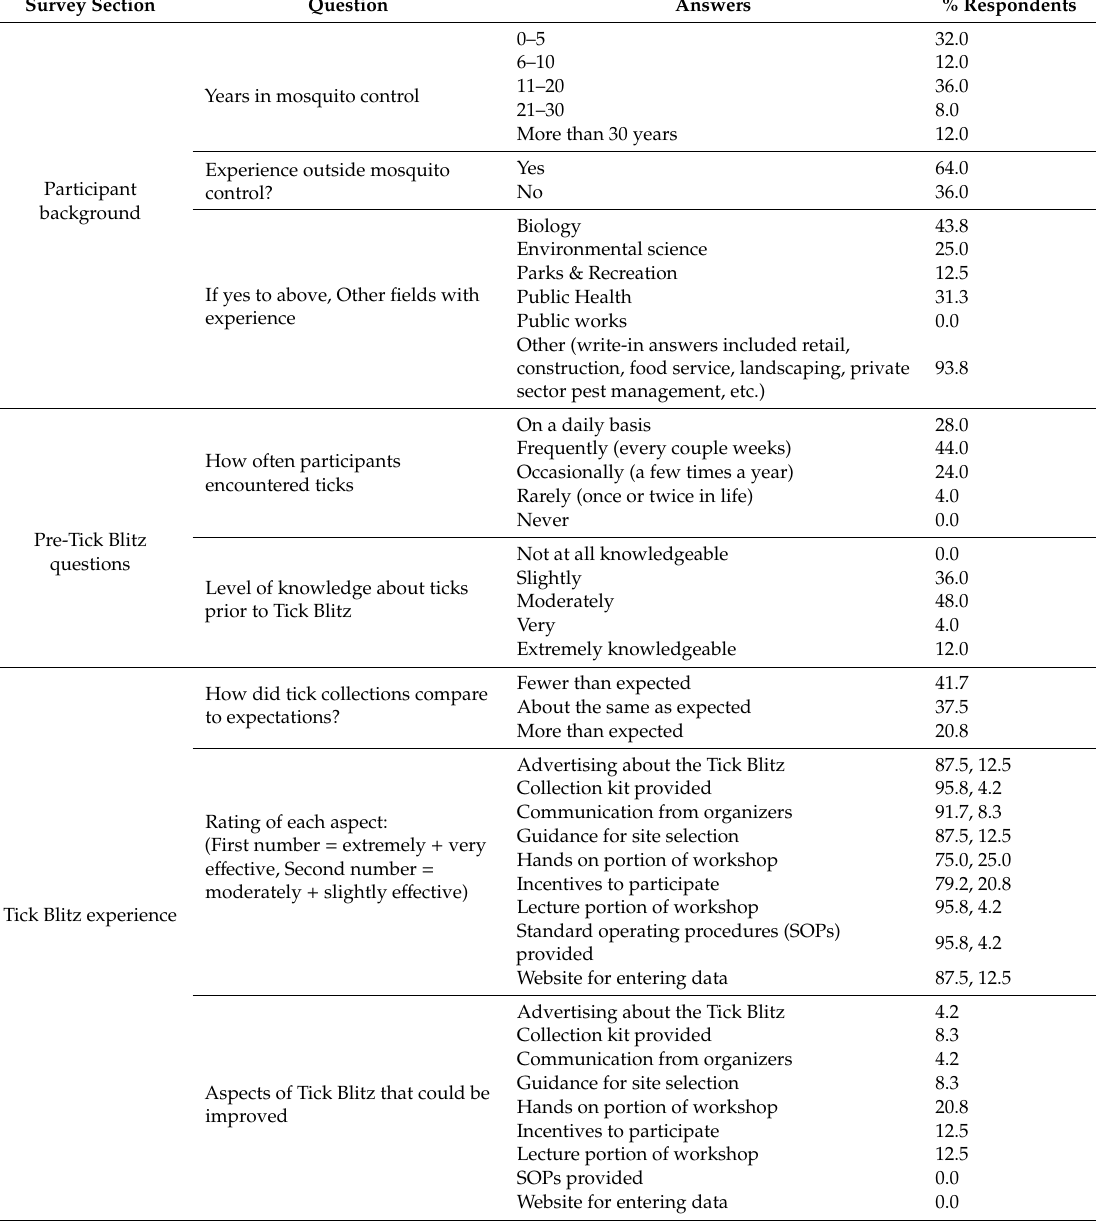
Table 2. Results of Final Survey of Tick Blitz participants, N = 25